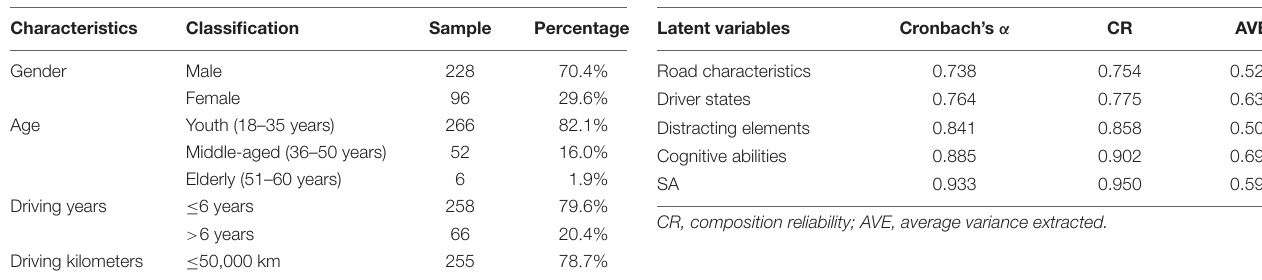
TABLE 2 | Results of descriptive statistics. TABLE 4 | Results of tests of reliability and validity.